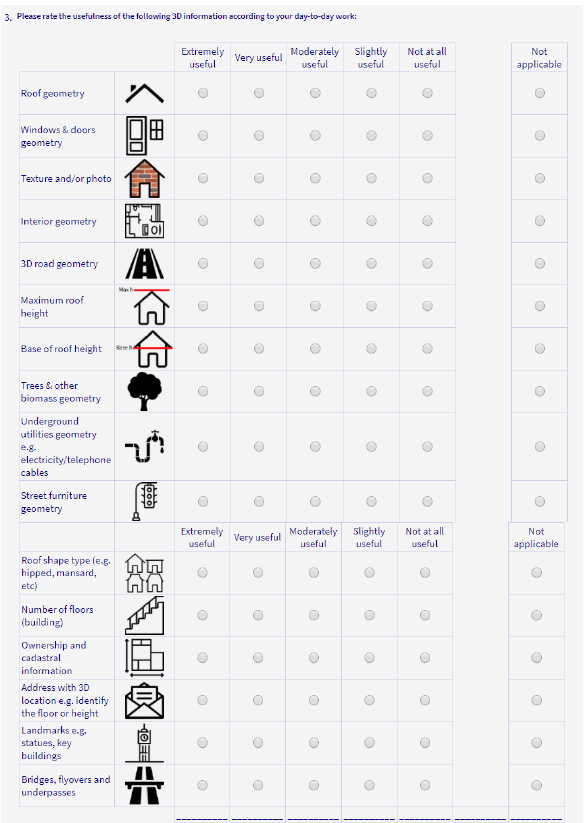
Figure 1. An excerpt of the ‘Usefulness of 3D’ web-based